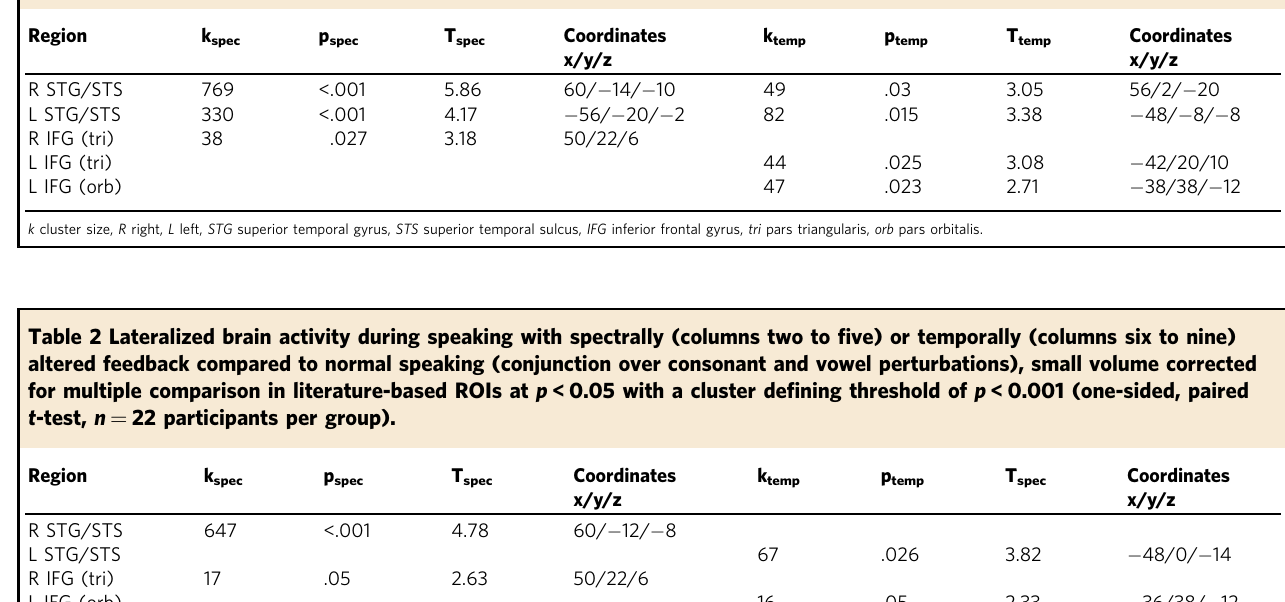
only region that translates deviations from sensory predictions into corrective motor commands that in turn are fed into the left- lateralized feedforward system. Our data indicate that the right auditory association cortex monitors preferentially spectral speech features while the left auditory association cortex pre- ferentially monitors temporal speech features (see Fig. 5). This